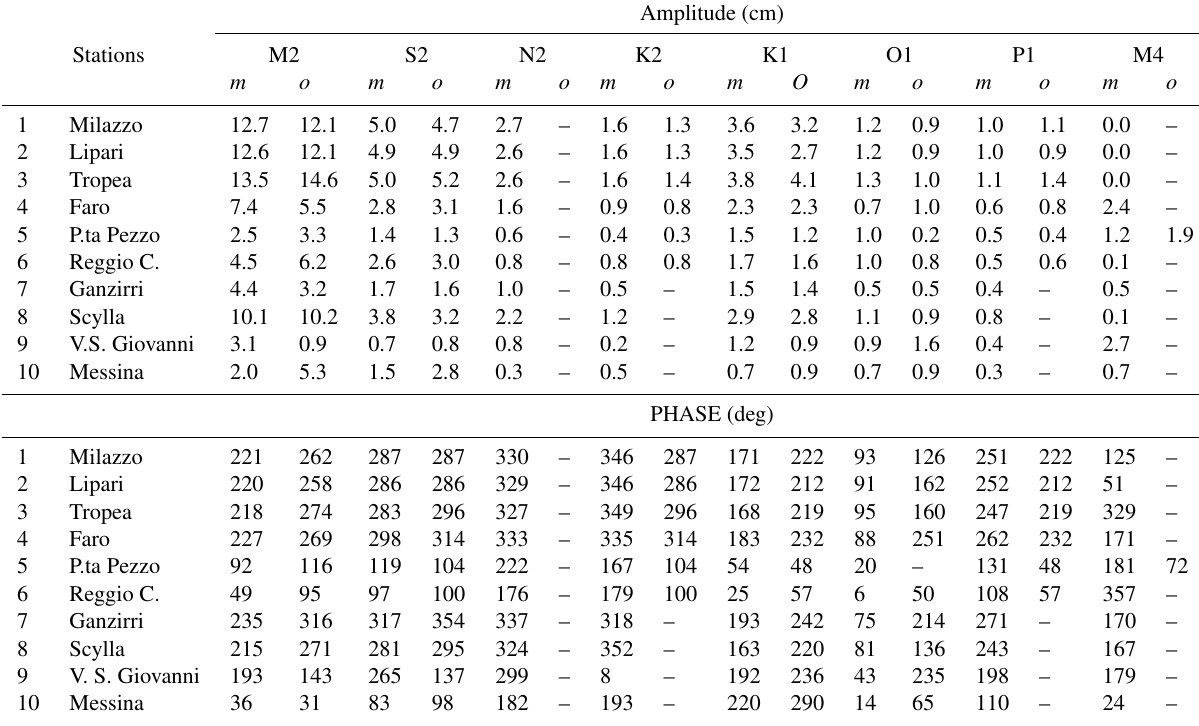
Table 2. Amplitude and phase of main harmonics observed ( o ) and computed ( m ) from calibrated model results in TDO scenario at the 10 tide gauge locations. Observed values for stations from 1 to 6 refer to Brandolini et al. (1980) for stations from 7 to 10 refer to Androsov et al. (2002a). Both authors refer to Vercelli